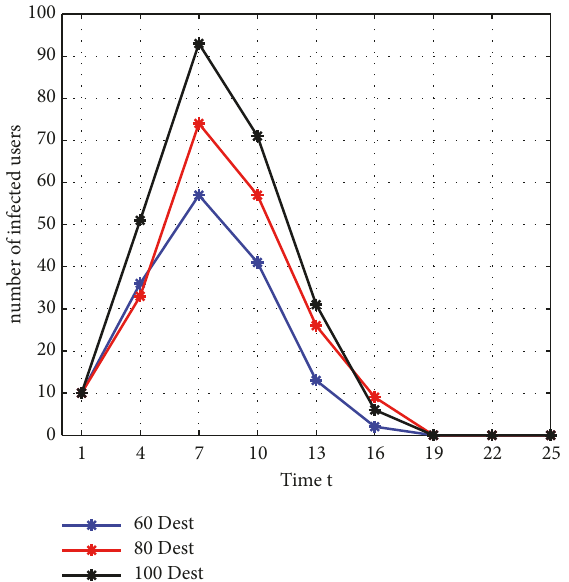
Figure 7: The evolution of infected users over time under different destinations.